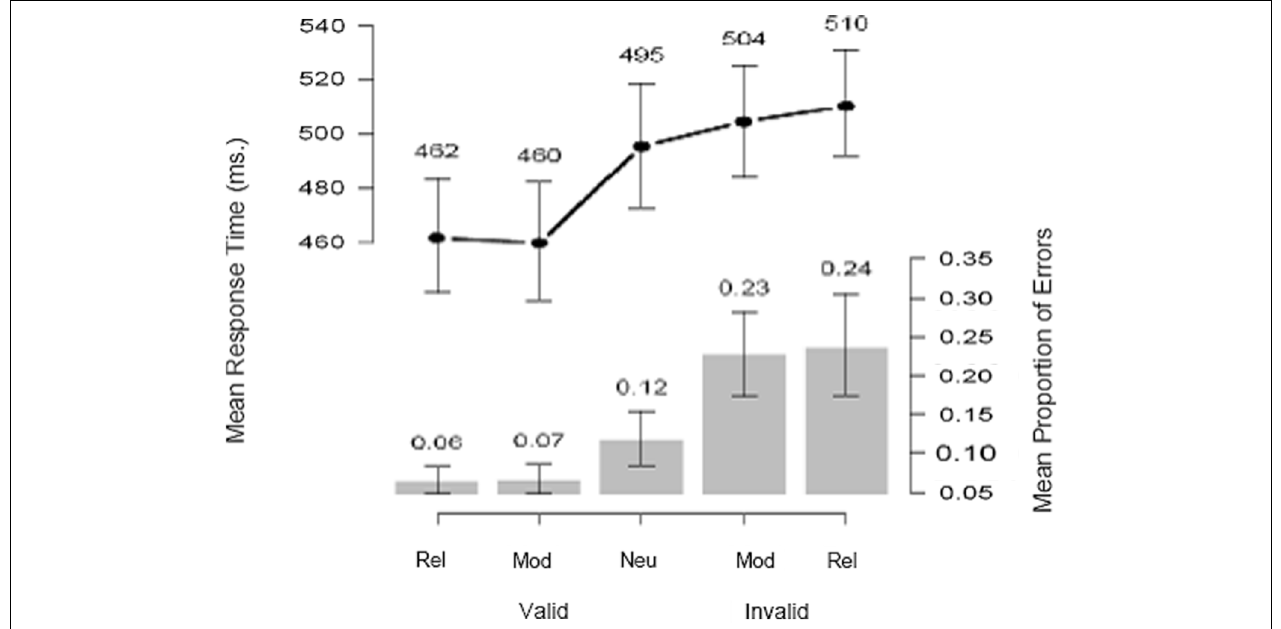
predict the direction of movement), and hurt performance when they are invalid. Error bars denote 95% confi dence intervals on the mean values, obtained by bootstrap resampling over